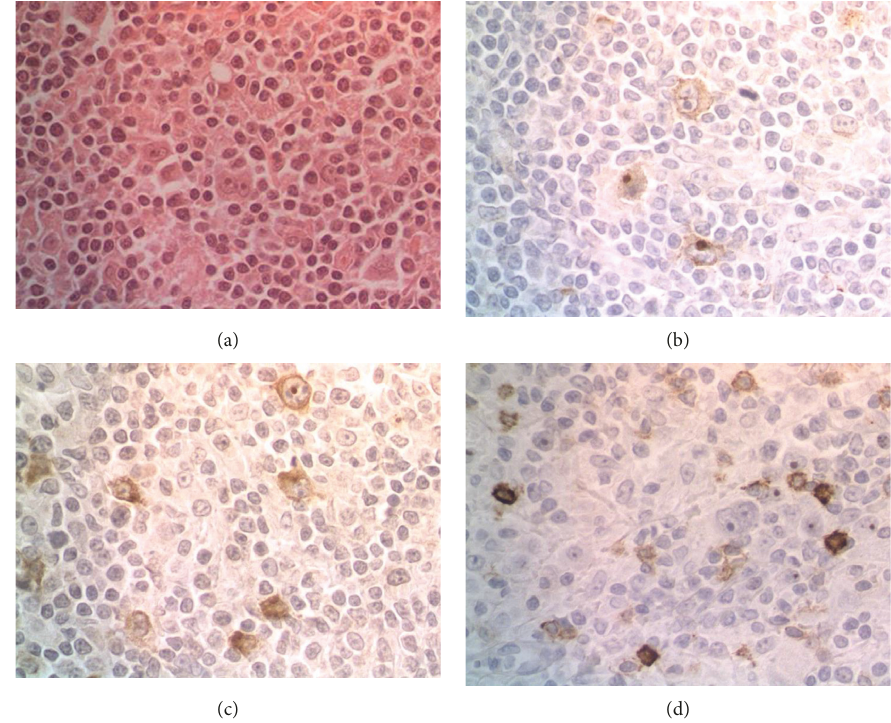
Figure 3: Lymph node biopsy sample. (a) Typical morphology of Reed–Sternberg cells, surrounded by a background of reactive in- flammation, nodular sclerosis pattern (HE stain × 40). Immunohistochemistry staining of the Reed–Sternberg population showed ex- pression of (b) CD15 and (c) CD30. (d) CD20 expression was